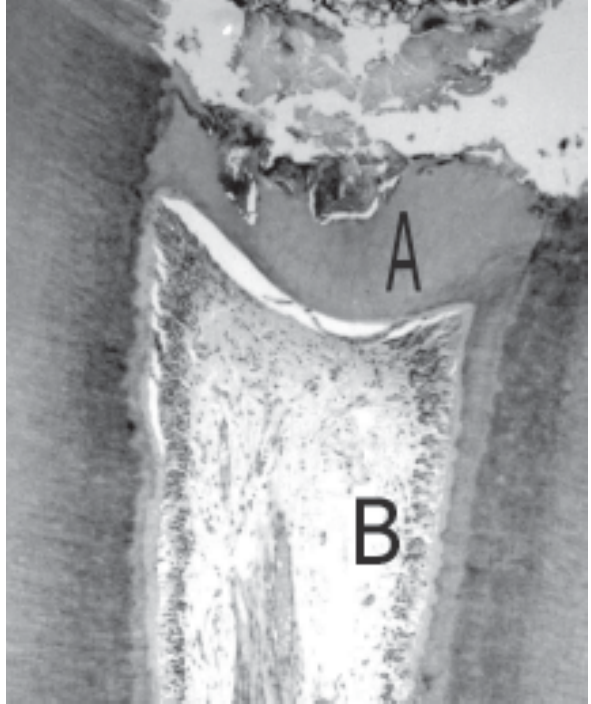
FIGURE 1 - MTA Angelus (120 days), H.E. 25 X. Note the presence of a mineralized barrier (A) sealing the pulp exposures. The connective pulp tissue presents characteristics of normality